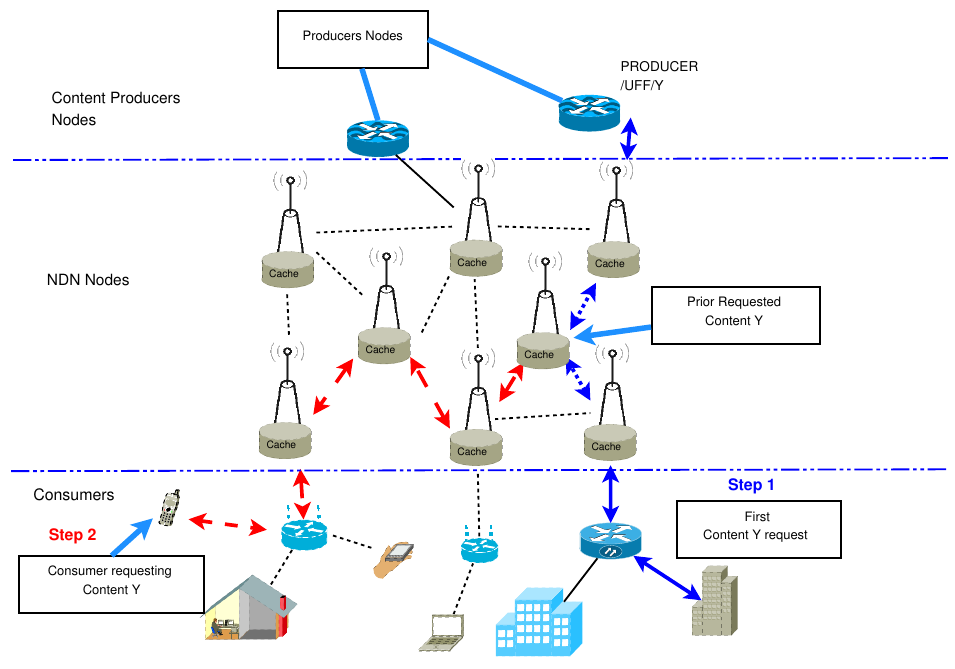
Figure 1. NDN-Based Wireless Mesh